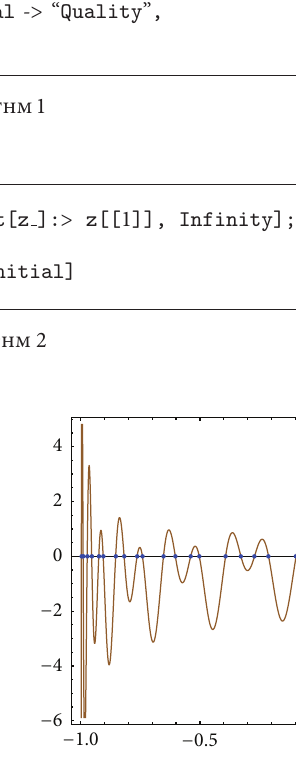
Figure 5: The plot of the function 𝑓(𝑥) along with its finitely many simple real zeros on the interval [−1,1]